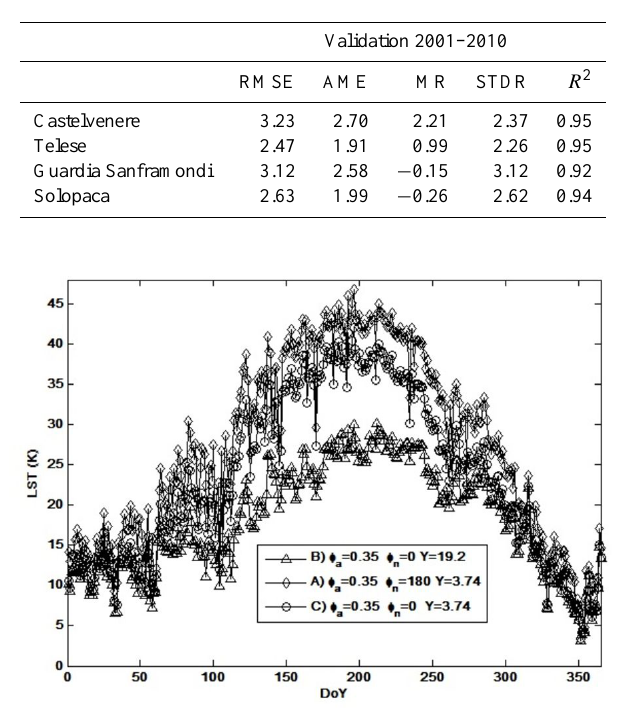
Fig. 7. Maximum (black diamonds; case A), minimum (black trian- gles; case B) and an arbitrary case (black circles; case C) selected out of the 24 yearly time series of LST estimated by Eqs. (8)–(13) applying the parameters in Table 8.